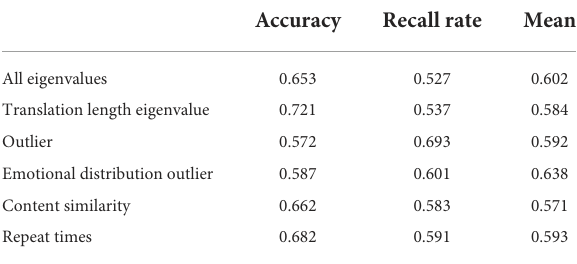
TABLE 4 Experimental result data of different